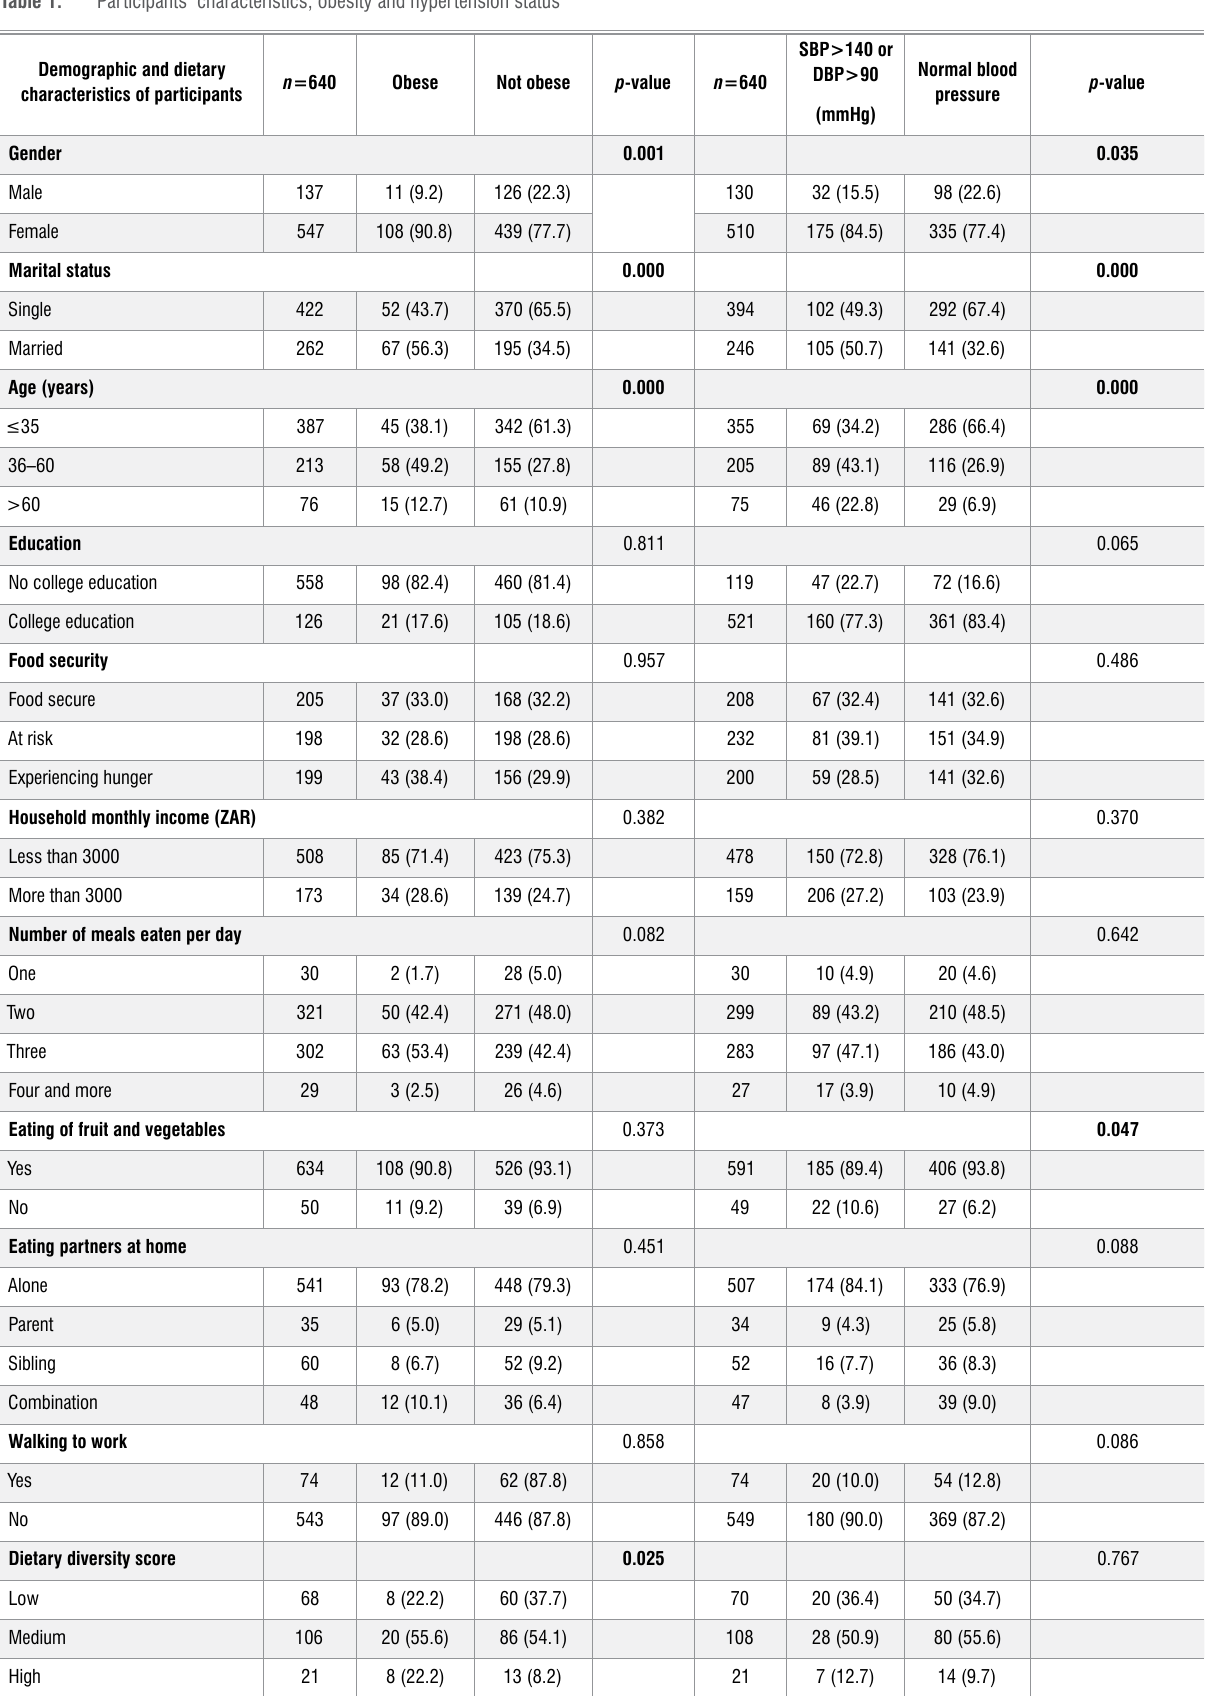
Table 1: Participants’ characteristics, obesity and hypertension status Demographic and dietary characteristics of